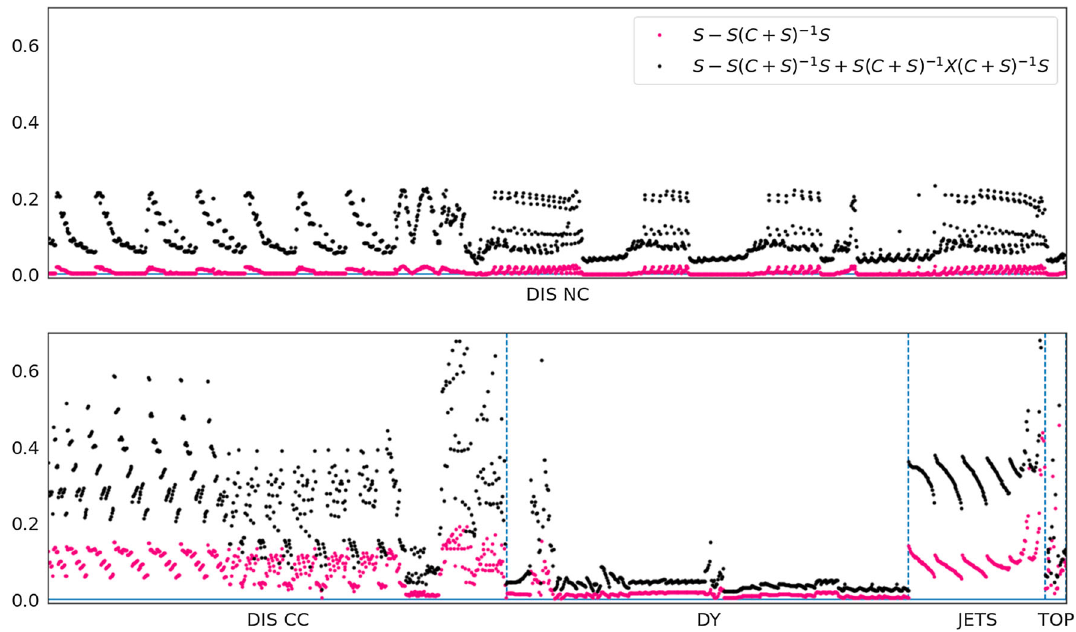
Fig. 10 The contributions to the diagonal elements of the correlated theory uncertainty normalised to diagonal elements of S: ( S − S ( C +